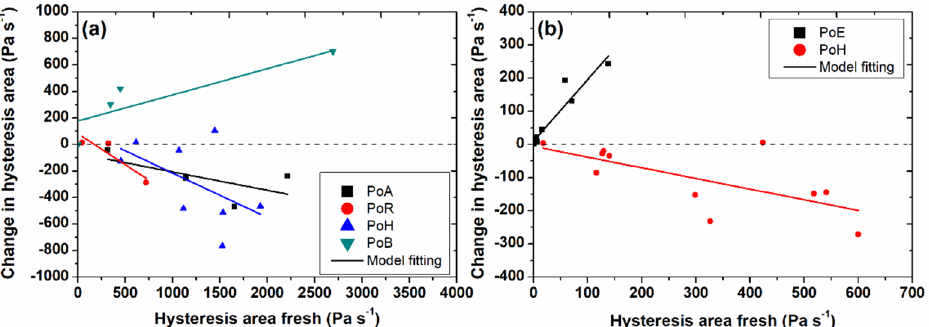
Figure 8. Change in hysteresis area (degraded–fresh) as a function of hysteresis area of fresh mud samples ( a ) from different ports and ( b ) from PoE and fluid mud samples from PoH. The dashed line represents the value where the degraded and fresh mud samples have the same hysteresis area. The solid line represents the empirical fitting using Equation (1).